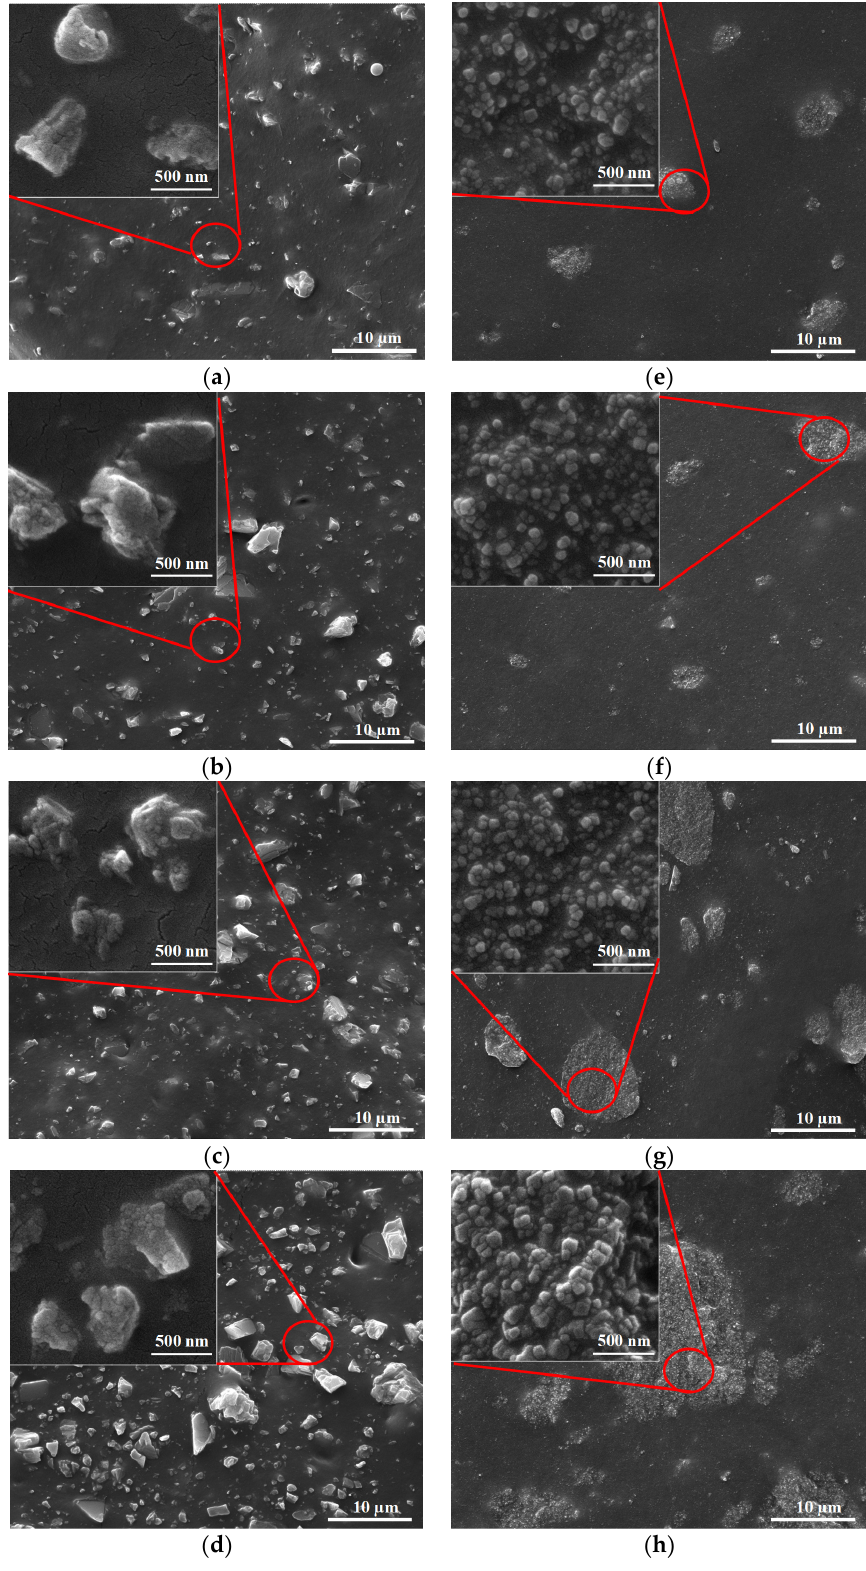
Figure2. SEMimagesofrubbercomposites: ( a )NR / MCC25phr, ( b )NR / MCC50phr, ( c )NR / MCC75phr, Figure 2. SEM images of rubber composites: ( a ) NR/MCC 25 phr, ( b ) NR/MCC 50 phr, ( c ) NR/MCC 75 phr, ( d ) NR/MCC 100 phr, ( e ) NR/NCC 25 phr, ( f ) NR/NCC 50 phr, ( g ) NR/NCC 75 phr, and ( h ) ( d ) NR / MCC 100 phr, ( e ) NR / NCC 25 phr, ( f ) NR / NCC 50 phr, ( g ) NR / NCC 75 phr, and ( h ) NR / NCC NR/NCC 100 phr. 100